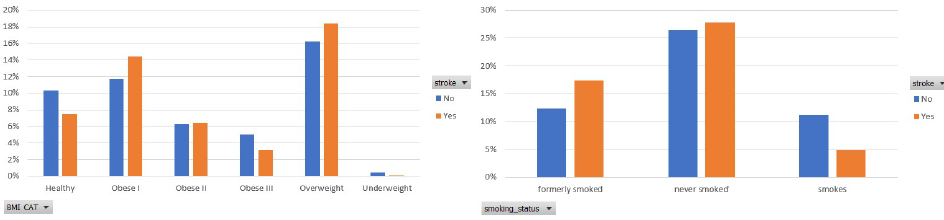
Figure 3. Participants distribution per BMI category and smoke status in the balanced dataset.